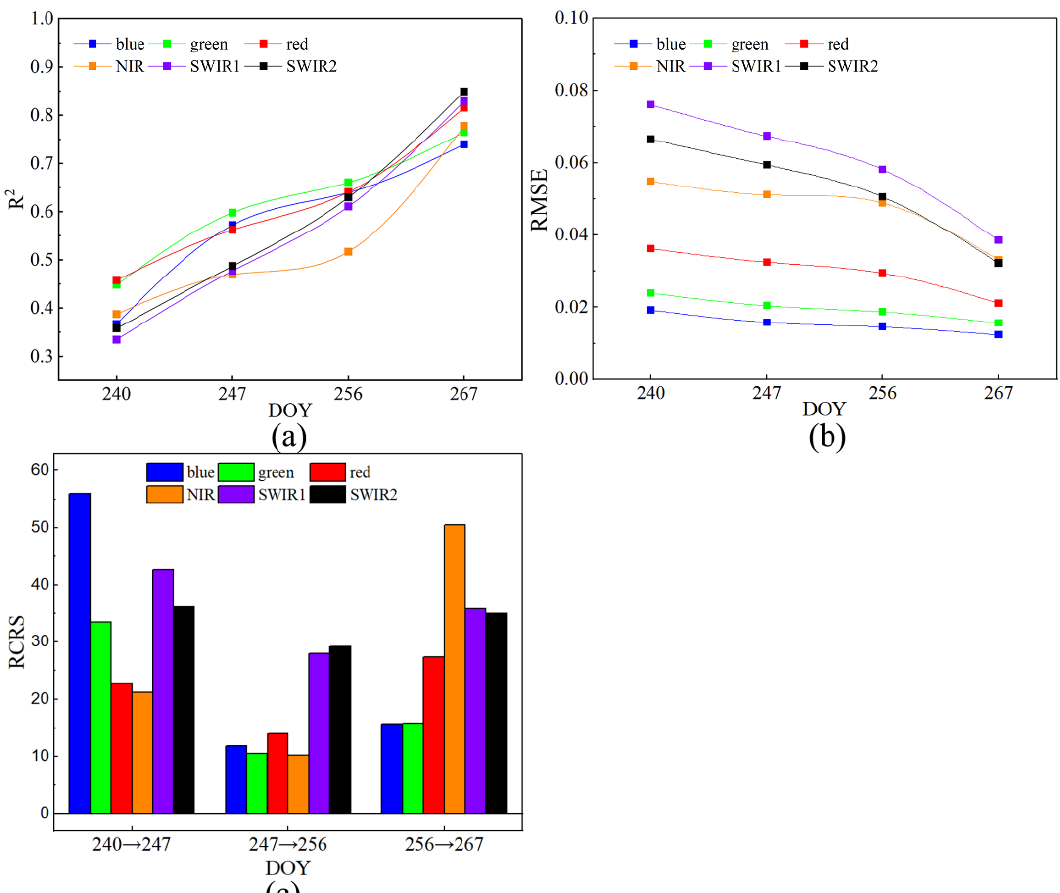
Figure 8. Accuracies of the fused images with different CDs for the MNLC period. ( a ) R 2 , ( b ) RMSE, and ( c ) RCRS (the horizontal axis indicates the DOY of the input CD image pairs for ( a , b ), and the change of DOY for ( c ); the vertical axis indicates the values of R 2 , RMSE, and RCRS, respectively).